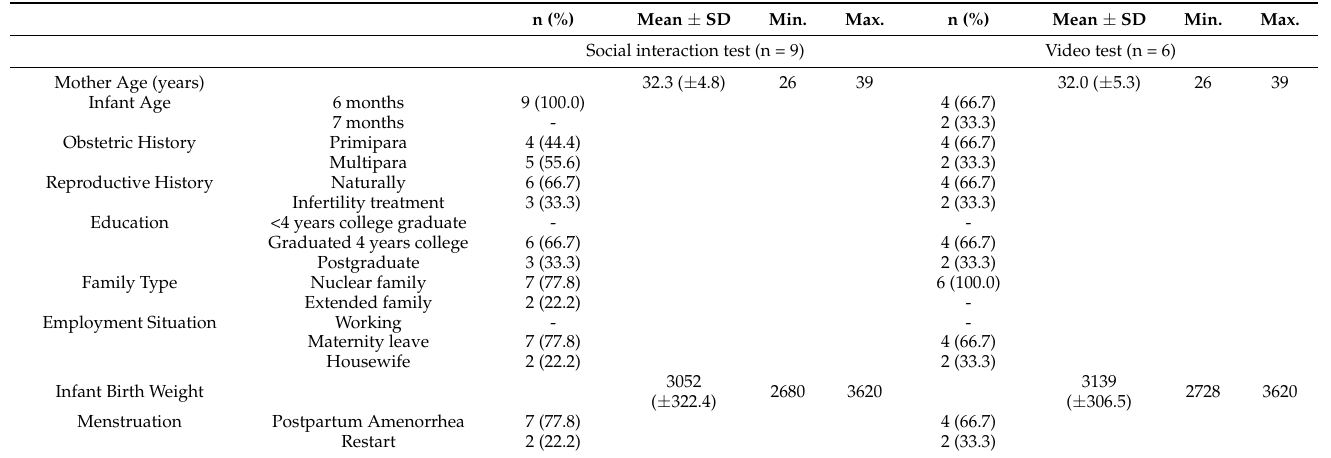
Table 1. Demographic and obstetric characteristics.